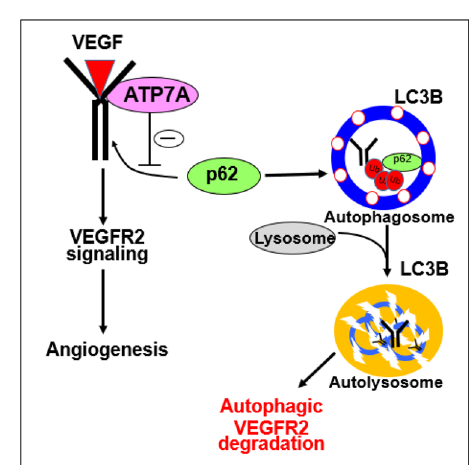
Fig. 7 Proposed model. Proposed model showing that ATP7A binds to VEGFR2 in endothelial cells in response to VEGF, which protects against p62/SQSTM1-mediated autophagic and lysosomal degradation of VEGFR2. This in turn promotes VEGFR2 signaling, thereby promoting angiogenesis and ischemic